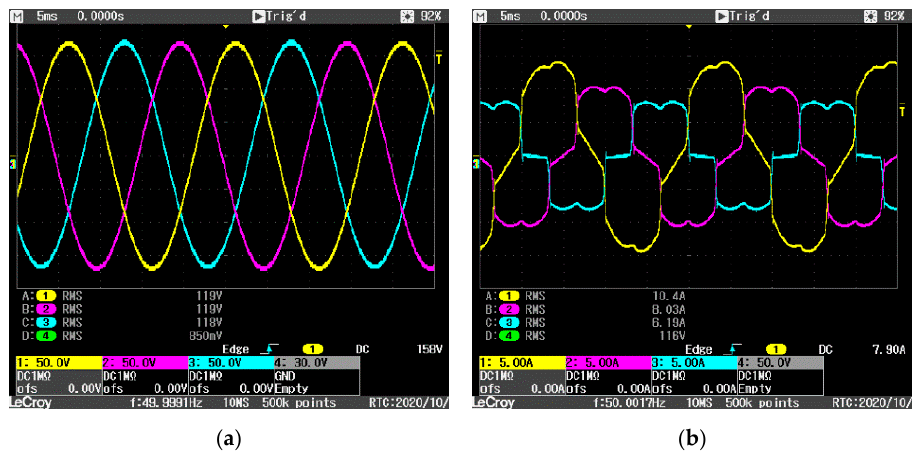
Figure 17. Supply voltages ( a ) and load current waveforms ( b ).